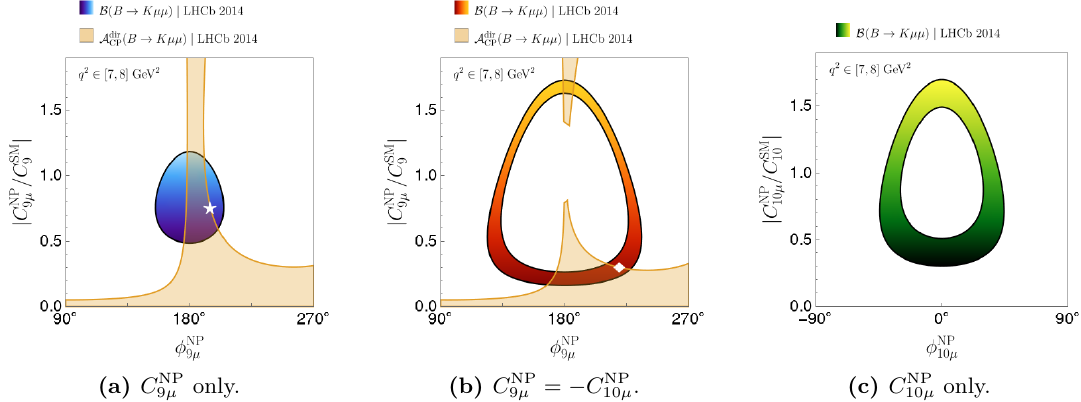
Figure 4 . Experimental 1 σ constraints on the three NP scenarios specified in (3.4). The star and diamond indicate Benchmark Points 1 and 2 given in (3.5), respectively. The colour gradients correspond to magnitudes of NP coefficients.